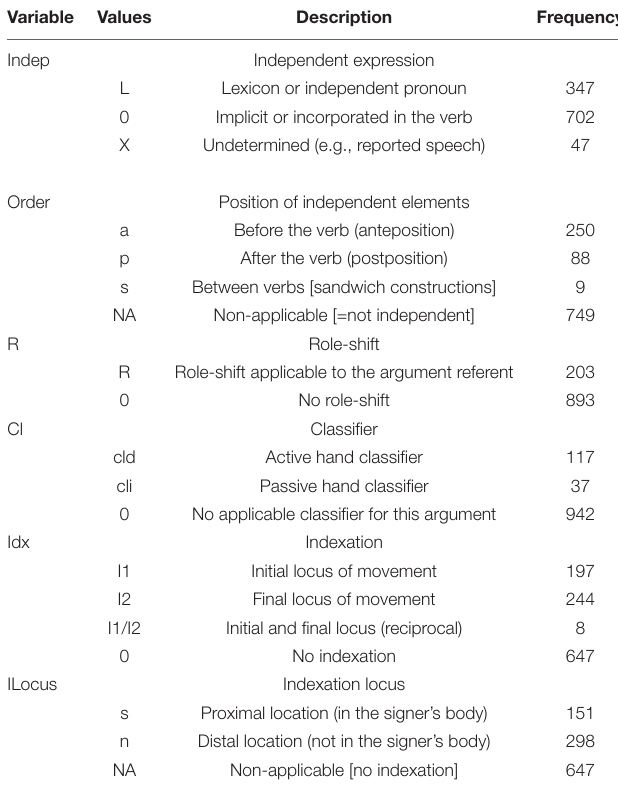
TABLE 4 | Analyzed descriptive variables and assigned